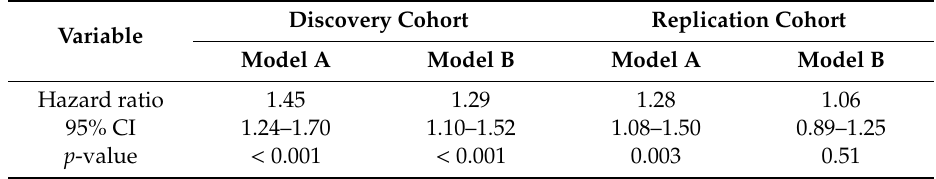
Table 3. Risk of composite outcome associated with the binary covariate elevated